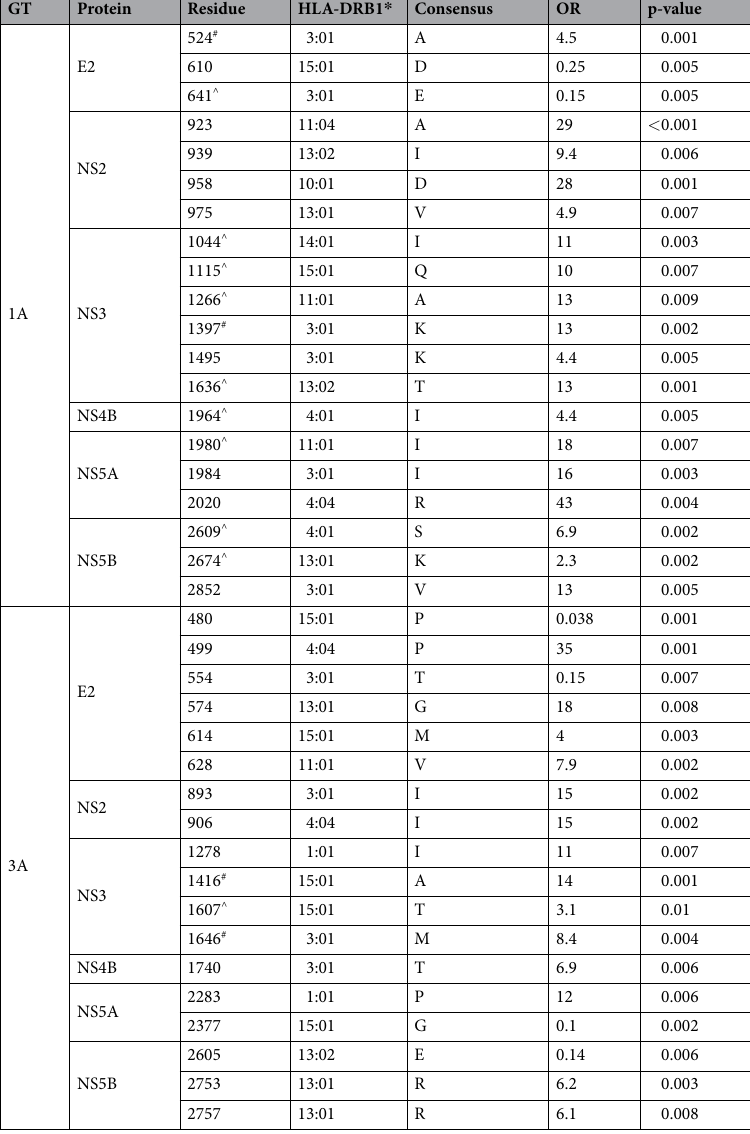
Table 2. HLA Class II-associated HCV variations for genotypes 1A and 3A. The association is given as the amino acid residue within the polyprotein and the HLA restriction. Overall N = 215 for genotype 1A and N = 136 for genotype 3A. Breakdown of HCV sequence numbers for each protein is shown in Supplementary Table 4. ^Indicates adaptations that fall within published epitopes for genotype 1 and with the same HLA restriction (http://www.immuneepitope.org). # HLA class I-associated variation at same site likely due to LD between HLA class I and II alleles known to form haplotypes. GT = genotype, OR = odds